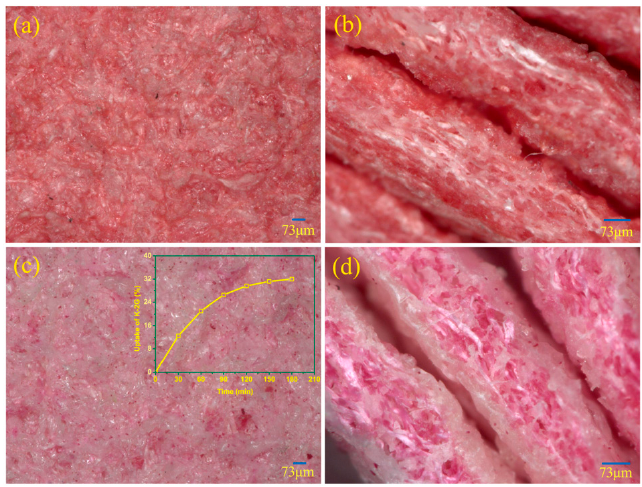
Figure 6. The micromorphologies of the MS-Leather bases: ( a ) surface of CLB; ( b ) cross section of CLB; ( c ) surface of DLB; and ( d ) cross section of DLB. The inset was the uptake curve of K-2G in the coloration of DLB.